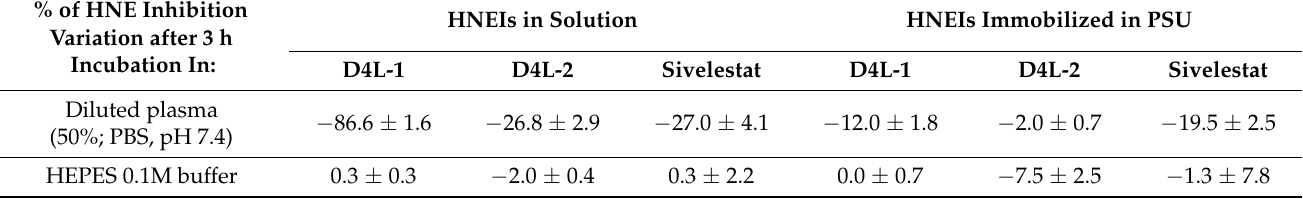
Table 3. Bioactivity comparison of HNEIs in solution versus immobilized on PSU membranes after 3 h incubation in diluted plasma or in HEPES